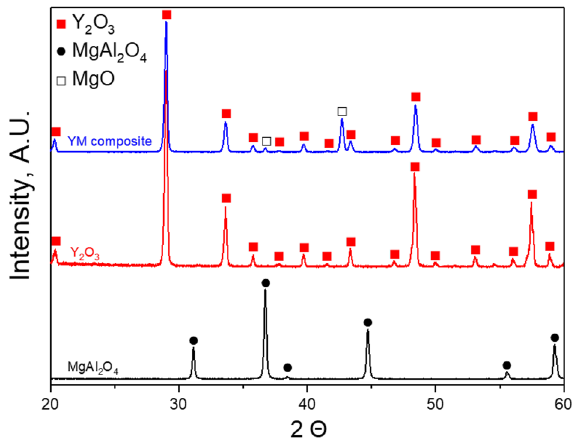
Figure 1. XRD patterns of YM composite, Y 2 O 3 and MgAl 2 O 4 ceramics.